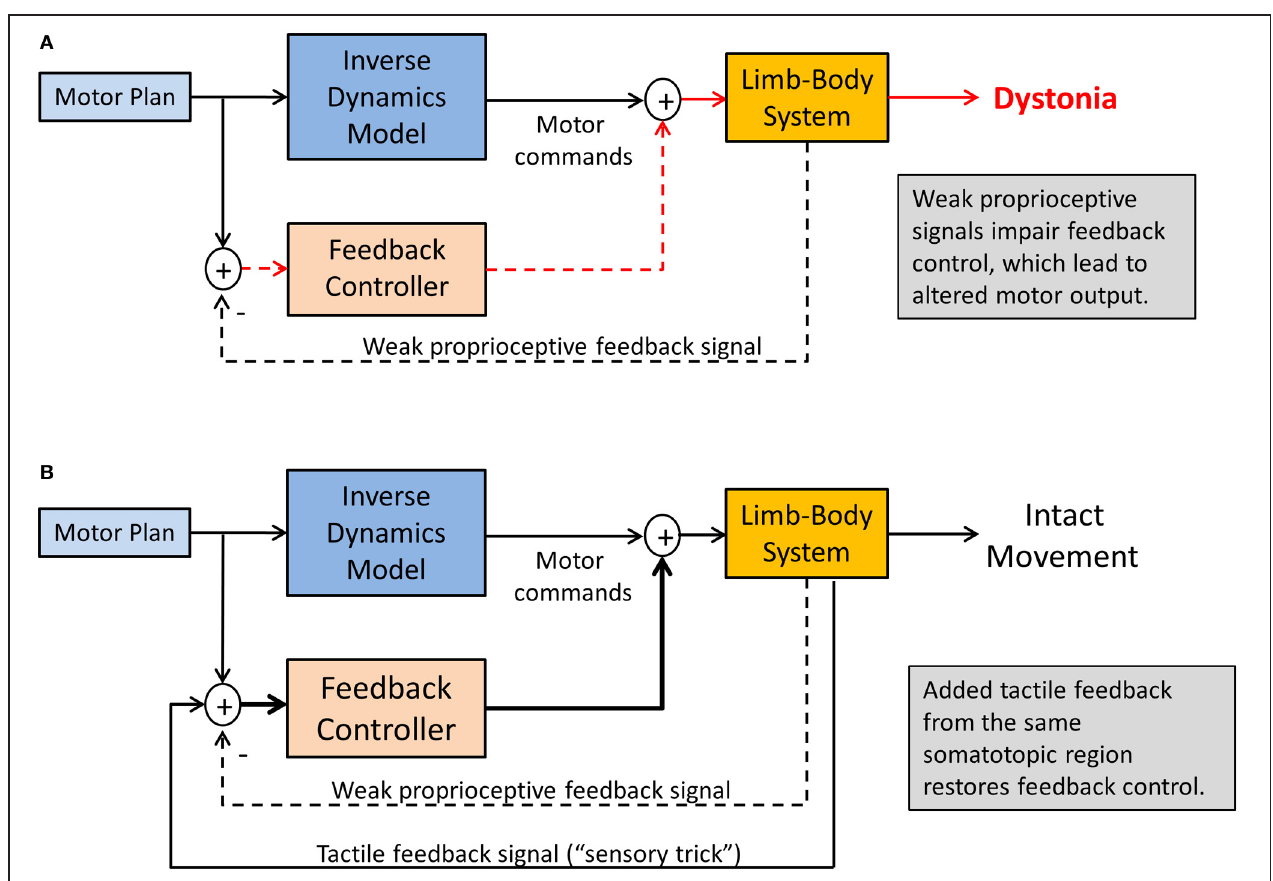
to the same somatotopic region of the dystonic musculature innervates multimodal tactile-proprioceptive neurons, essentially amplifying the proprioceptive signals. This will improve feedback control of muscle tone, resulting in symptom relief as long as tactile feedback is